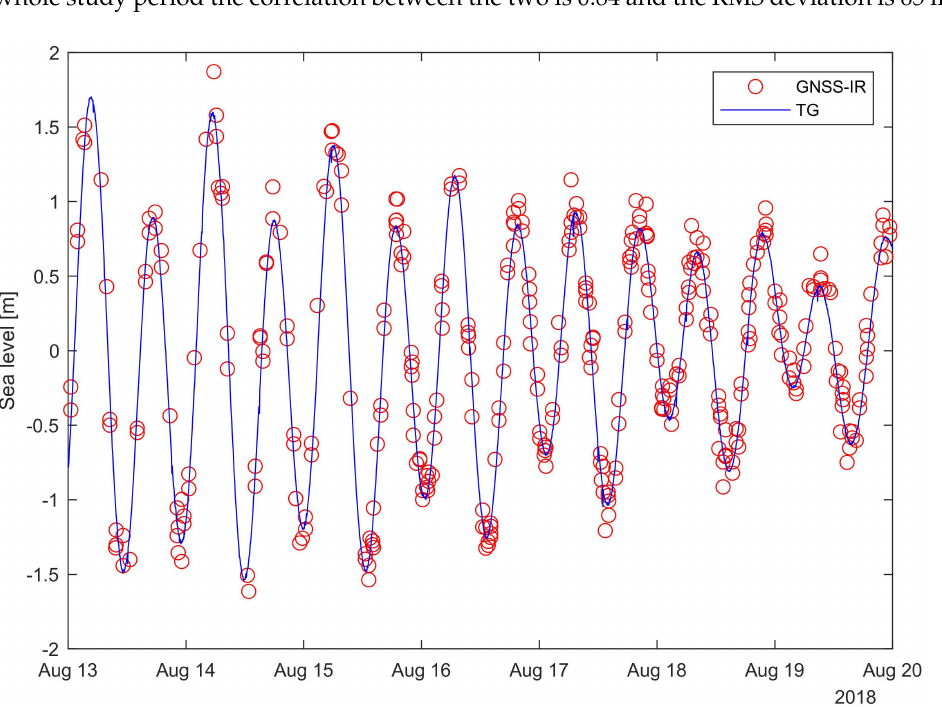
Figure 4. Individual measurements of sea level variation using GNSS Interferometric Reflectometry (GNSS-IR) and Tide Gauge (TG) from one week in August 2018 (13 to 19 of